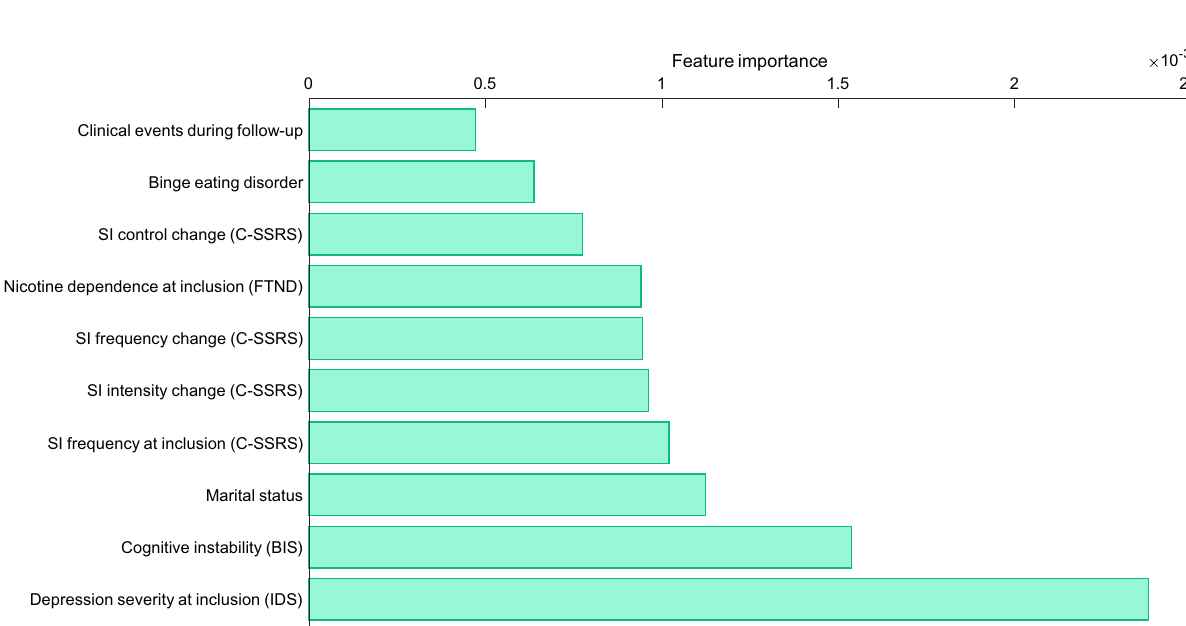
Figure 5. Importance of the ten clinical and demographic features used by the random forest to automatically discriminate patients in the low- and high-variability groups. For clarity, the y-axis is sorted in increasing importance order according to the random forest. The importance is computed by summing all changes in the impurity of the nodes from the parent to the two children thanks to a given clinical feature and its corresponding surrogate splits. Impurity is a measure of how the decisions of a node can separate patients in the low- and high-variability groups and it is measured by the Gini’s diversity index. The sum of impurity changes is normalized by the number of branch